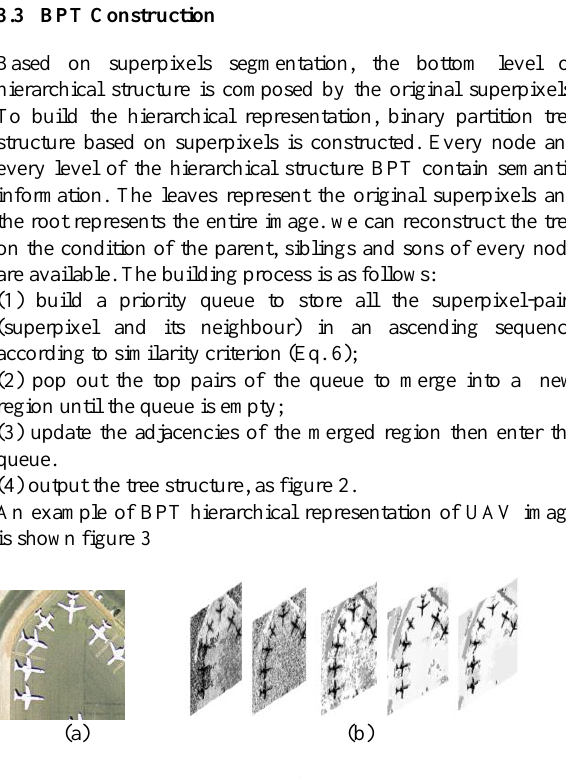
Figure 3 representation of several levels on BPT.